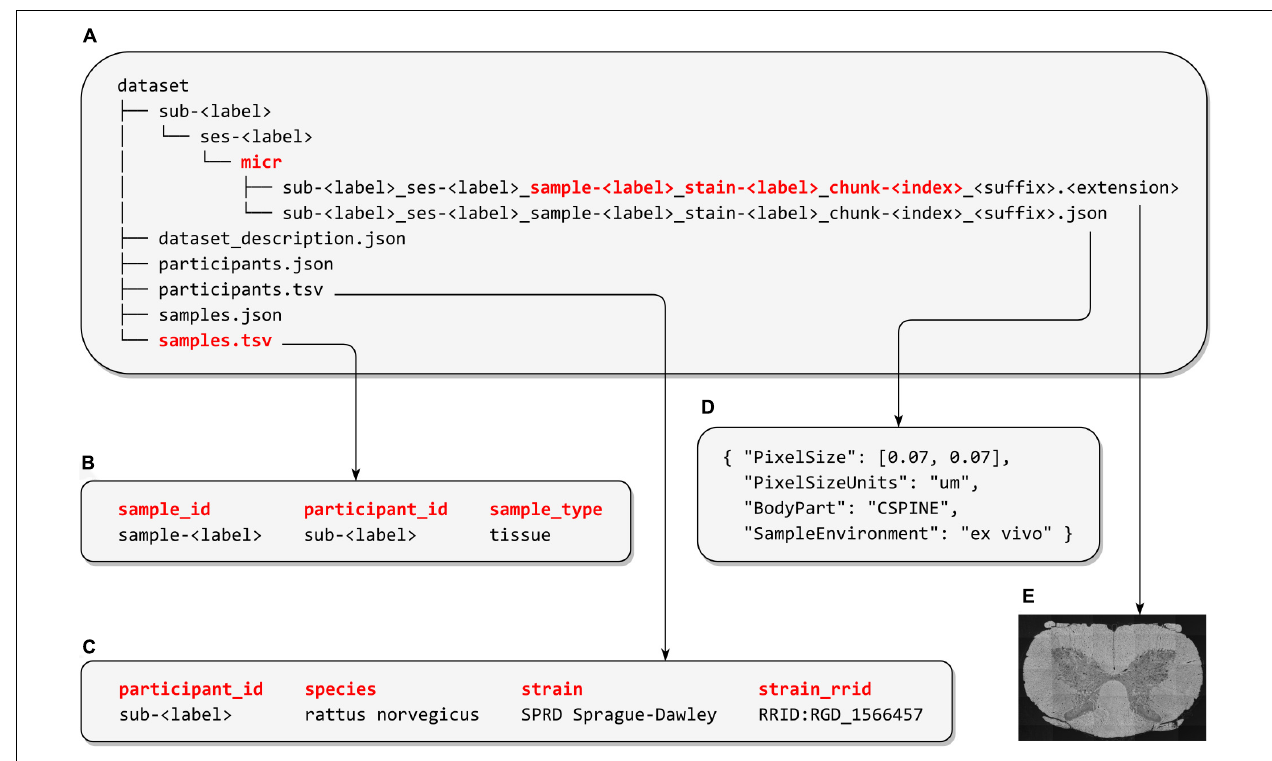
FIGURE 1 | Microscopy-BIDS overview. (A) Microscopy-BIDS dataset hierarchy. The raw imaging data files and their sidecar JSON files are stored in the “sub- < label > ” directory, followed by the optional “ses- < label > ” (session) directory and then the data type “micr” directory. The new “sample- < label > ”, “chunk- < label > ”, and “stain- < label > ” entities are shown in red in the image filename. (B) Example of “samples.tsv” file describing sample attributes such as “sample_type”. (C) Example of “participants.tsv” file including animal metadata (“species”, “strain”, and “strain_rrid”). (D) Example of sidecar JSON metadata file. (E) Raw microscopy imaging data modified from Zaimi et al. (2018) under Creative Commons Attribution 4.0 International License